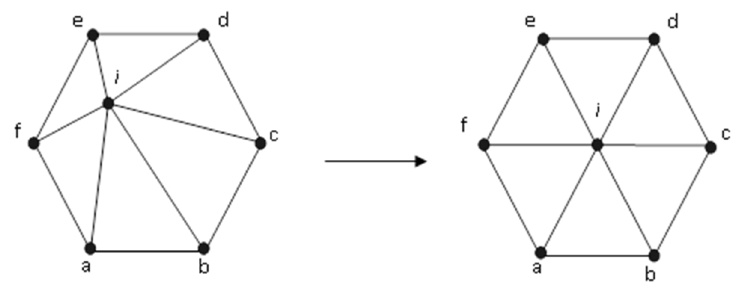
Figure 3. Laplacian smoothing, repositioned of node i.